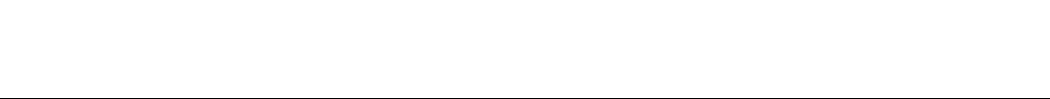
Segregated Roma colonies Complementary area p -value a Written Dispensed Dispensed Written Dispensed Dispensed prescriptions prescriptions percentage prescriptions prescriptions